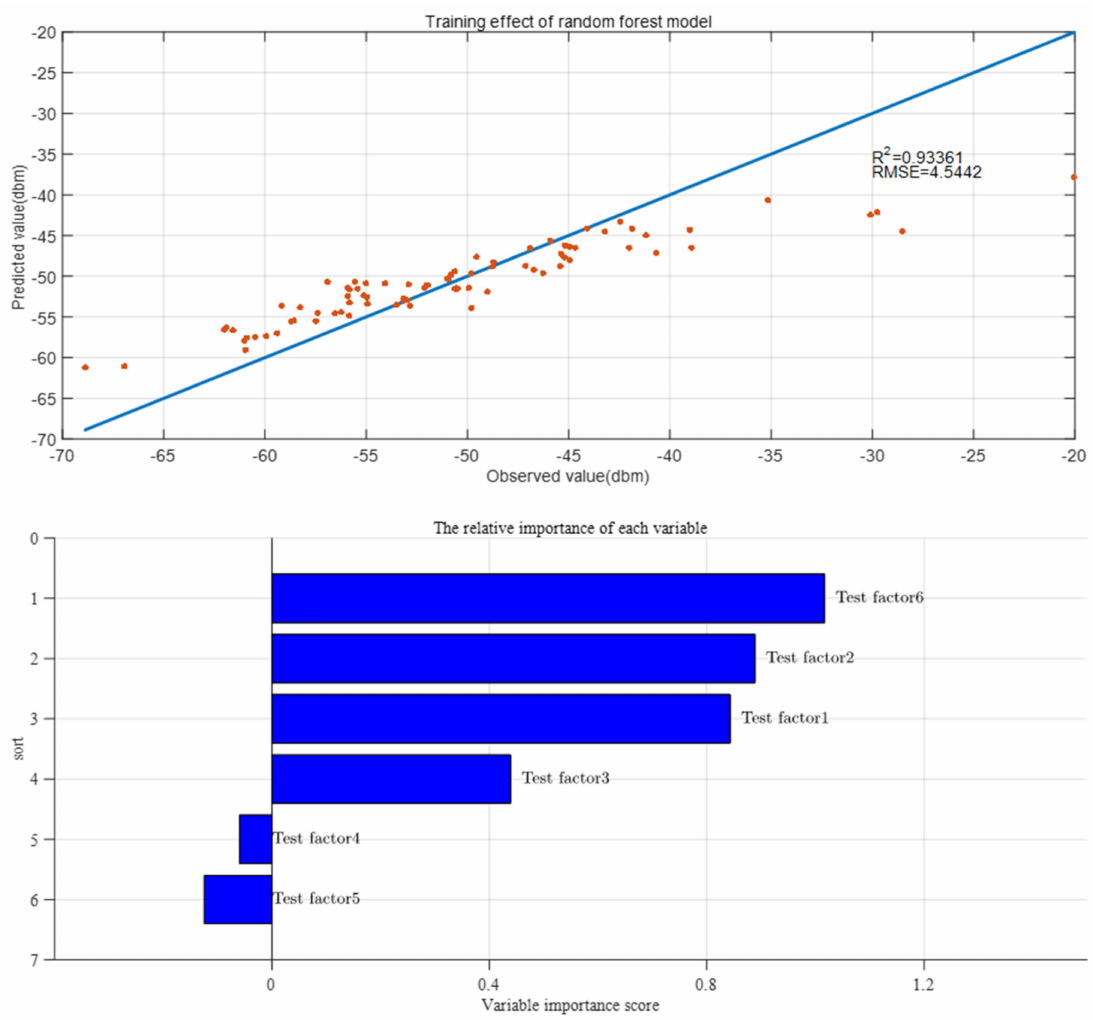
Figure 6. Training results of random forest algorithm ( upper ) Training effect of random forest model; ( lower ) the random forest model algorithm to evaluate the importance of